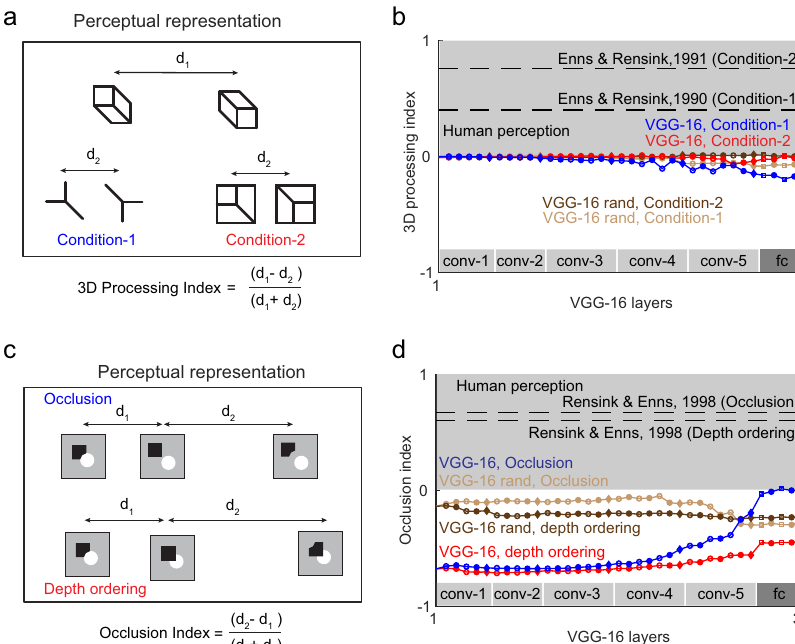
Fig. 5 3D processing in deep networks. a Perceptual representation of sensitivity to 3D shape 27 . Three equivalent image pairs are shown in perceptual space. The fi rst image pair (with distance marked d 1) consists of two cuboids at different orientations, and represents an easy visual search, i.e. the two objects are dissimilar. The second pair (marked with distance d 2) contains the same feature difference as in the fi rst pair, but represents a hard search, i.e. is perceived as more similar. Likewise, the third pair (also marked with distance d 2), with the same feature difference as the fi rst image pair, is a hard search, i.e. perceived as similar. b 3D processing index for the VGG-16 network across layers, for condition 1 ( blue ) and condition 2 ( red ), and for the VGG- 16 with random weights (dark brown and light brown). Dashed lines represent the estimated human effect measured using visual search on the same stimuli. c Perceptual representation of occluded shapes. Top: A square alongside a disk is perceptually similar to a display with the same objects but occluded, but dissimilar to a 2D control image with an equivalent feature difference. Bottom: A square occluding a disk or disk occluding square are perceptually similar, but dissimilar to an equivalent 2d control with the same set of feature differences. d Occlusion index for the occlusion ( blue ) and depth ordering ( red ) effects for each layer of the VGG-16 network, and for the randomly initialized VGG-16 ( dark brown and light brown ). Dashed lines represent the effect size in humans measured using visual search on the same